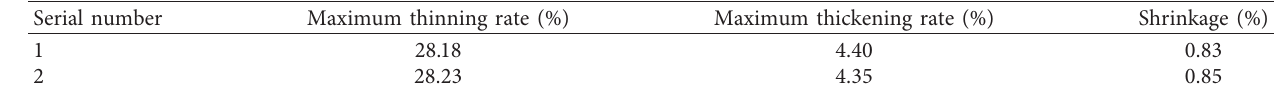
Table 9: Quality test of trunk trim